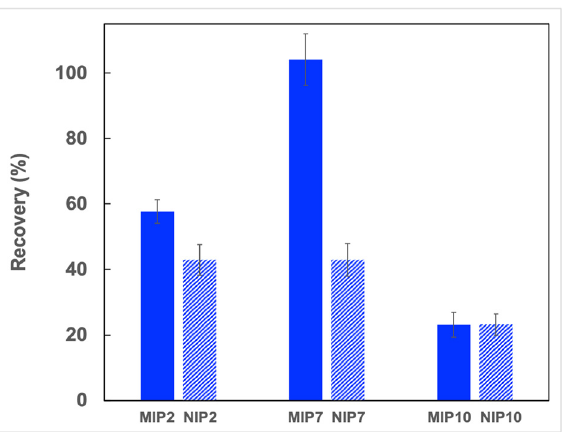
Figure 7. CIP recoveries from different imprinted and non-imprinted polymers (SPE condition: 40 mg of polymer, loading: 5 mL CIP solution in water (0.1 μ g L − 1 ), washing: 3 mL of deionized water, eluting: 3 mL of methanol/acetic acid (9:1; v / v ), n = 3).